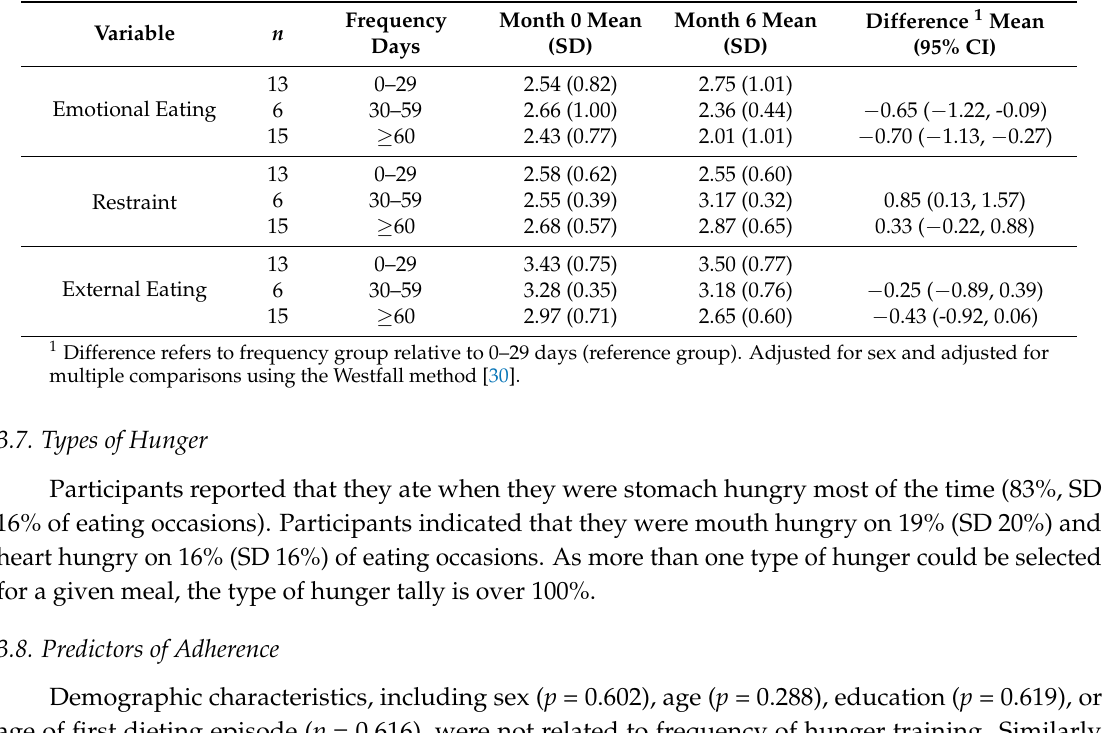
Table 6. Effect of frequency of hunger training on eating behaviours as measured by the Dutch Eating Behaviour